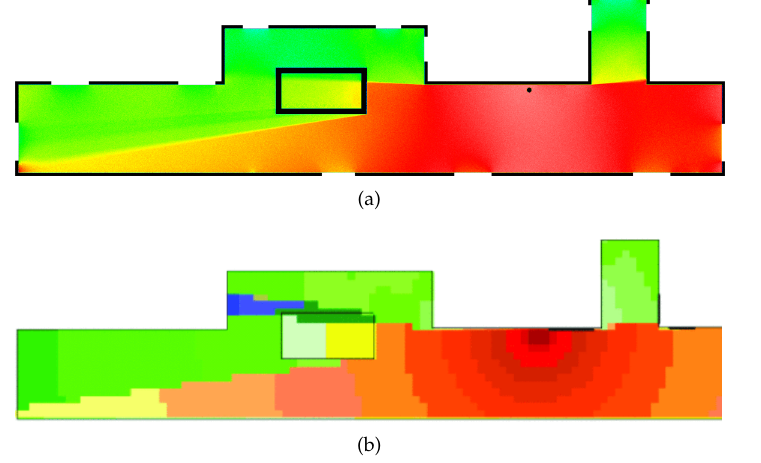
Figure 10. RTg heat map of antenna 1 ( a ) and Multi-Wall heat map ( b ) (taken from